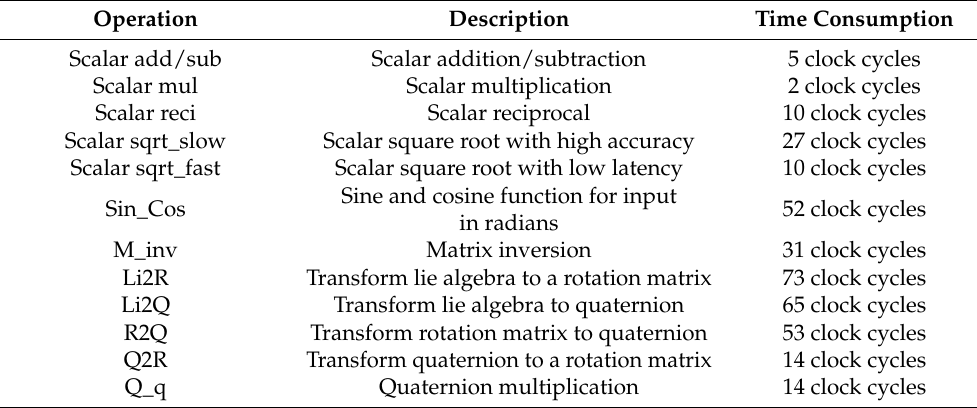
Table 2. Description and time consumption of operations supported by the computation